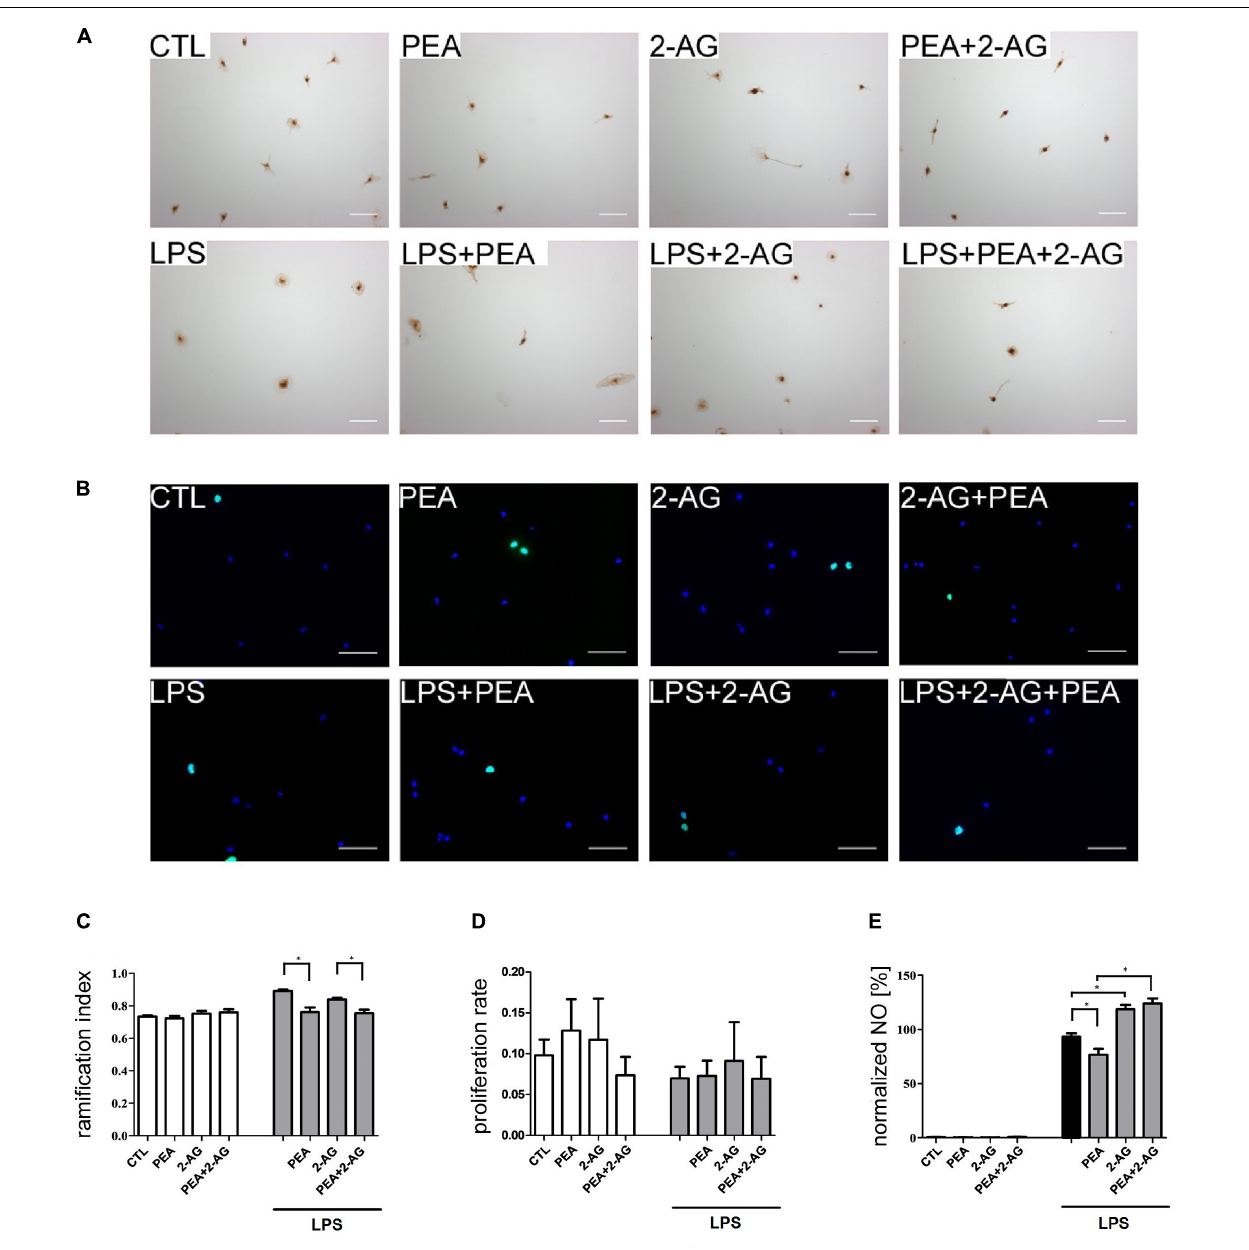
FIGURE 3 | Effect of 2-AG and PEA on ramification index, proliferation index and nitrite concentration of primary rat microglia. Representative pictures of stained microglia for (A) ramification index (IB 4 ) and (B) proliferation rate (BrdU in green, DAPI in blue). Scale bar = 50 µ m. (C) Effects of 2-AG and PEA on ramification index. Application of LPS (n LPS = 22) led to an increase in the ramification index in comparison to control group (CTL; n CTL = 22). Whereas PEA co-applied with LPS (n LPS + PEA = 23) reduced the ramification index significantly, 2-AG (n LPS + 2 − AG = 23) had no effect. 2-AG, PEA, or combination of both applied alone (n PEA = 19, n 2 − AG = 22, n 2 − AG + PEA = 22) had no effect on ramification index. The combination of LPS, 2-AG and PEA (n LPS + 2 − AG + PEA = 22) led to decrease in the ramification index in comparison to the groups treated with LPS and 2-AG. (D) No effect of 2-AG and PEA with/or without LPS on proliferation of primary microglia cells could be observed (n CTL = 12, n LPS = 12, n PEA = 11, n 2 − AG = 11, n 2 − AG + PEA = 12, n LPS + PEA = 12, n LPS + 2 − AG = 11, n LPS + 2 − AG + PEA = 12). (E) Effects of 2-AG and PEA on nitrite concentration after 72 h. PEA, 2-AG, or PEA combined with 2-AG had no effect on the nitrite concentration in primary microglia (n CTL = 18, n PEA = 18, n 2 − AG = 18, n 2 − AG + PEA = 18). After administration of LPS, nitrite concentration increased significantly. PEA co-applied with LPS (n LPS + PEA = 18) decreased the NO production in comparison to LPS (n LPS = 18). 2-AG+LPS (n LPS + 2 − AG = 18) and also 2-AG+PEA+LPS ( nLPS + 2 − AG + PEA = 18) treated microglia produced significantly more NO in comparison to LPS. Statistics was performed using a one-way ANOVA test with Bonferroni correction and significance was chosen for p < 0.05. The asterisk denotes significant results regarding the respective measurement indicated with the bar. The values are served as a mean with standard error of the mean.